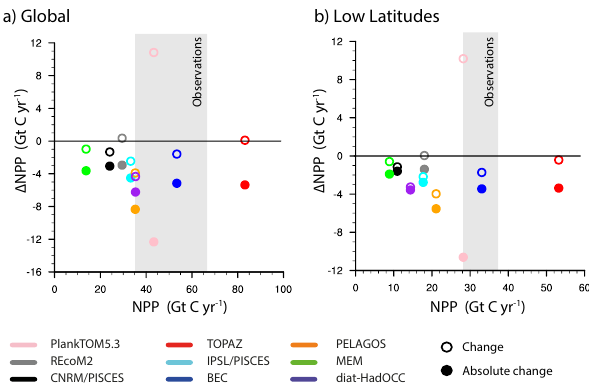
Figure 13. Relationship between the change in NPP and the 2012– 2031 average NPP for all models. Change in NPP has been calcu- lated as the sum of the differences between the 2012–2031 average and the 2081–2100 average for each grid cell (open dots). We addi- tionally show the negative absolute differences of the changes (full dots), calculated by taking the sum of the negative absolute differ- ences between the 2012–2031 average and the 2081–2100 average for each grid cell. Each color represents a model, (a) shows global values and (b) shows the low latitudes. The gray area marks the range of current observational NPP estimates. For global values we show the observed NPP range as reported by Carr et al. (2006); for the low latitudes we give the observed NPP range spanned by the estimates of Behrenfeld and Falkowski (1997) and Westberry et al.